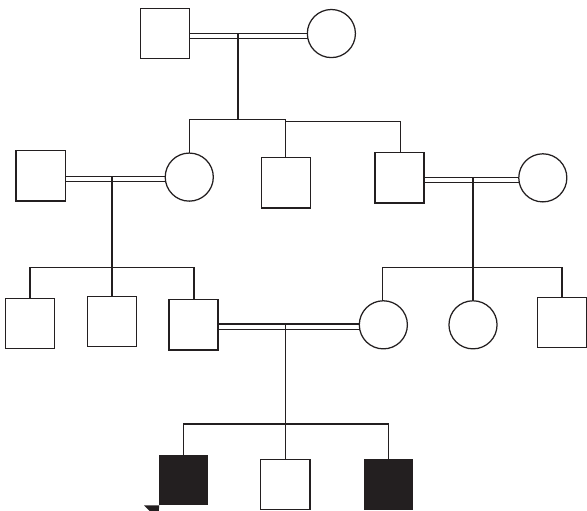
Figure 1: Pedigree chart of the patient. The pedigree chart shows the consanguineous marriages in three generations and the manifestation of the disease in our patient and possibly in his